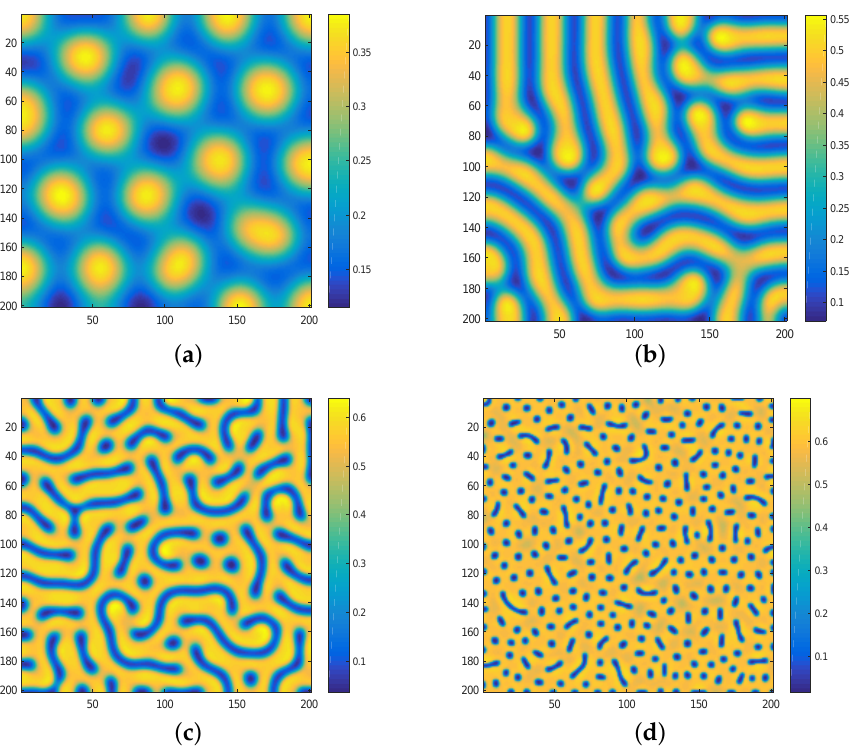
Figure 6. The patterns of the prey with different values at d 1 , the other parameters are fixed as in (24). Types: ( a ) d 1 = 0.12, ( b ) d 1 = 0.04, ( c ) d 1 = 0.01, ( d ) d 1 =